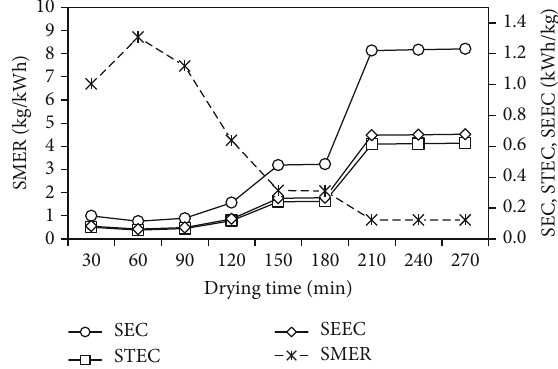
Figure 12: Variation of SMER, SEC, STEC, and SEEC with drying time.